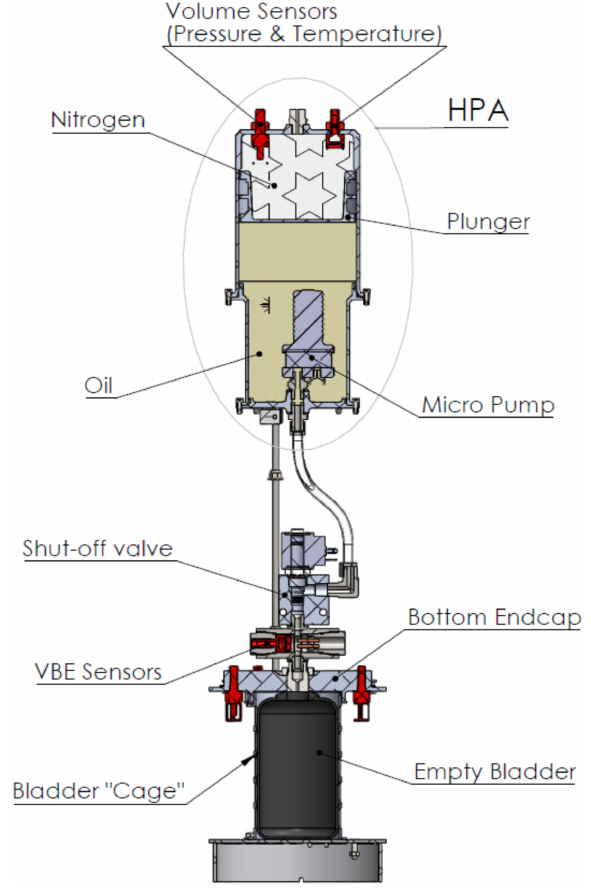
Figure 4. VBE model